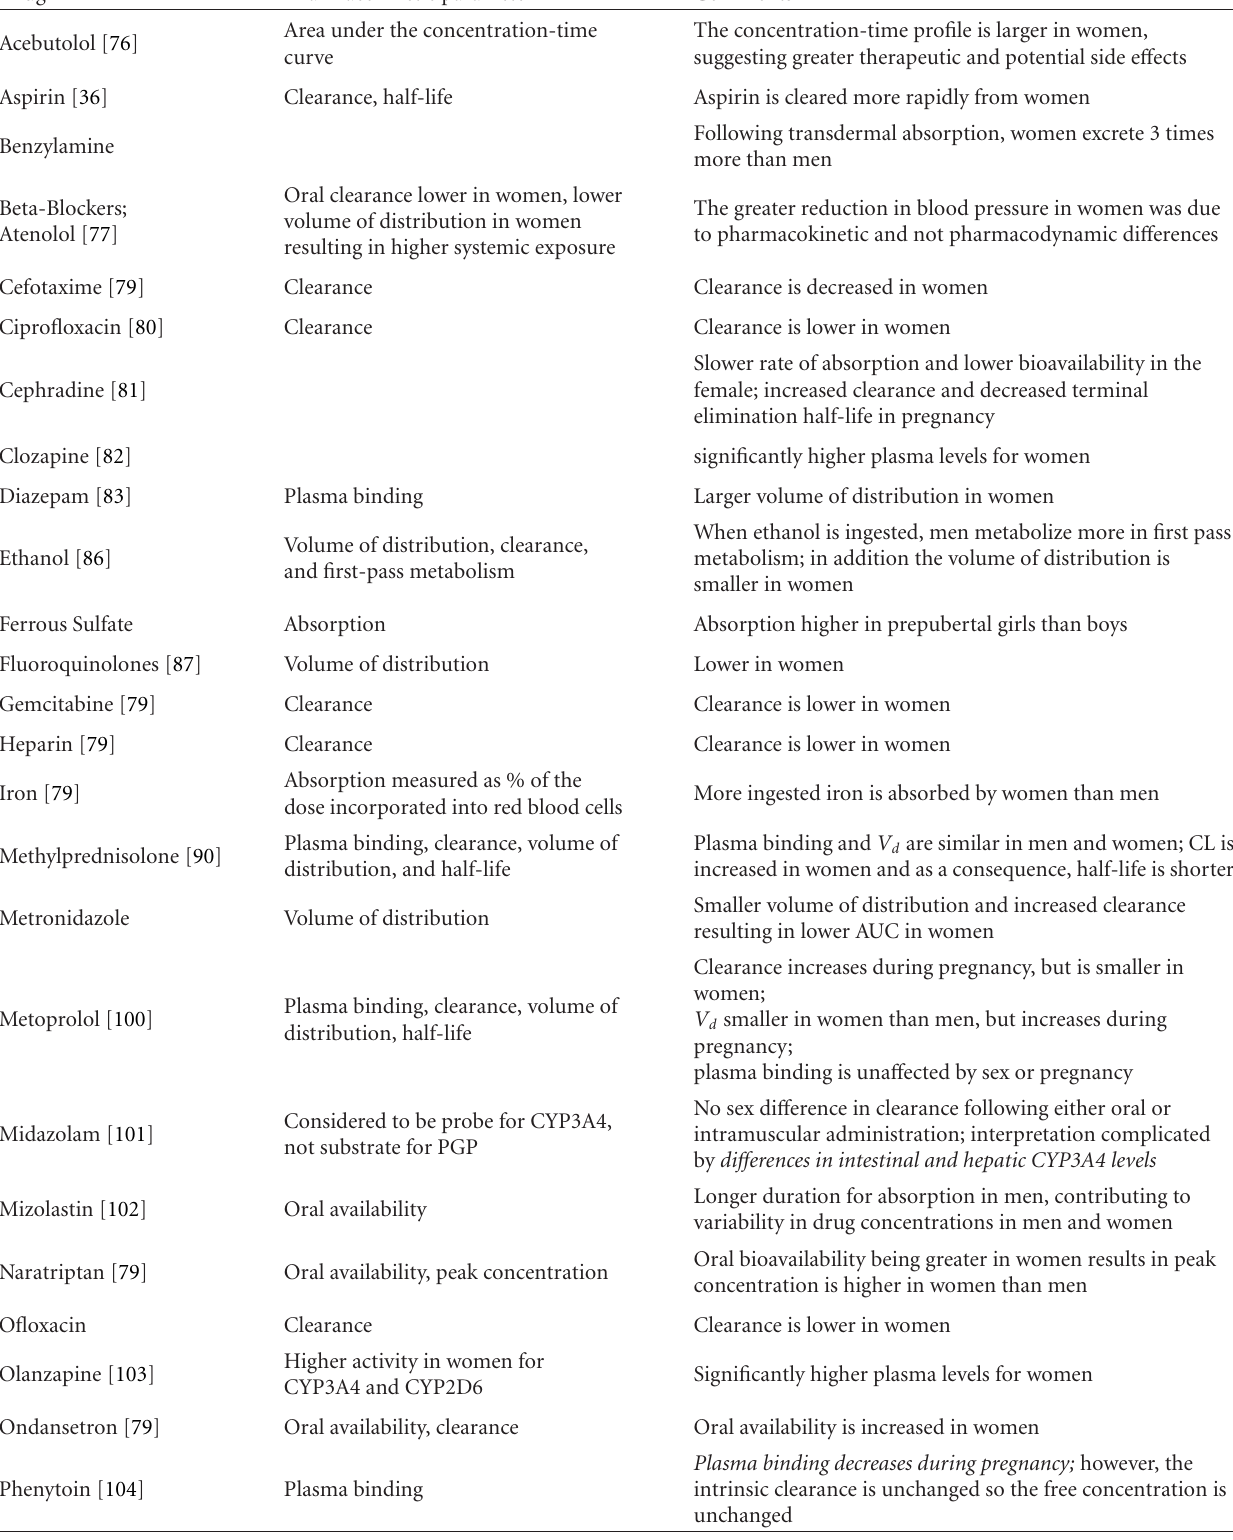
Table 4: Some drugs that display sex di ff erences in pharmacokinetics.